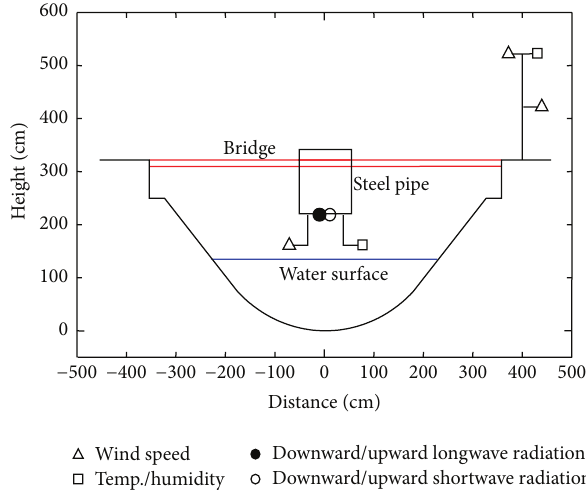
Figure 3: Cross section of the main canal and observation instru- ments installed at